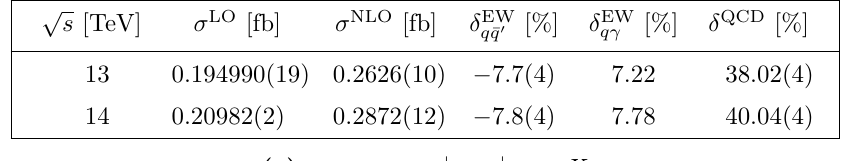
p s of a proton-proton collision. Monte Carlo integration